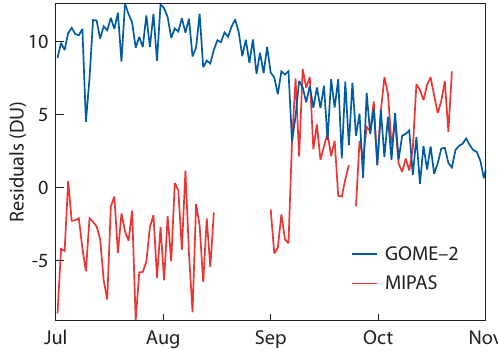
Figure 4. Time series of the global mean analysis departures for GOME-2 NPO 3 (blue line) and MIPAS LPO 3 (red line) over the pe- riod July–October 2008. Statistics are shown as integrated columns computed over the GOME-2 and MIPAS common vertical grid spanning 0.05 to 100hPa. Data are in